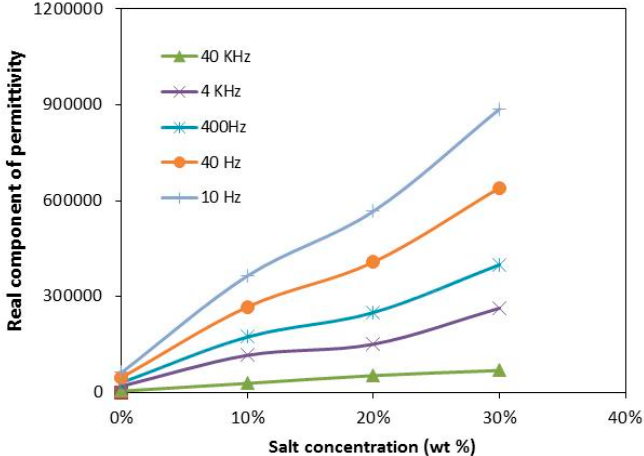
Figure 4. The plots of the real component of permittivity variation concentration at various frequencies for CMKC/CMCE-LiI films.